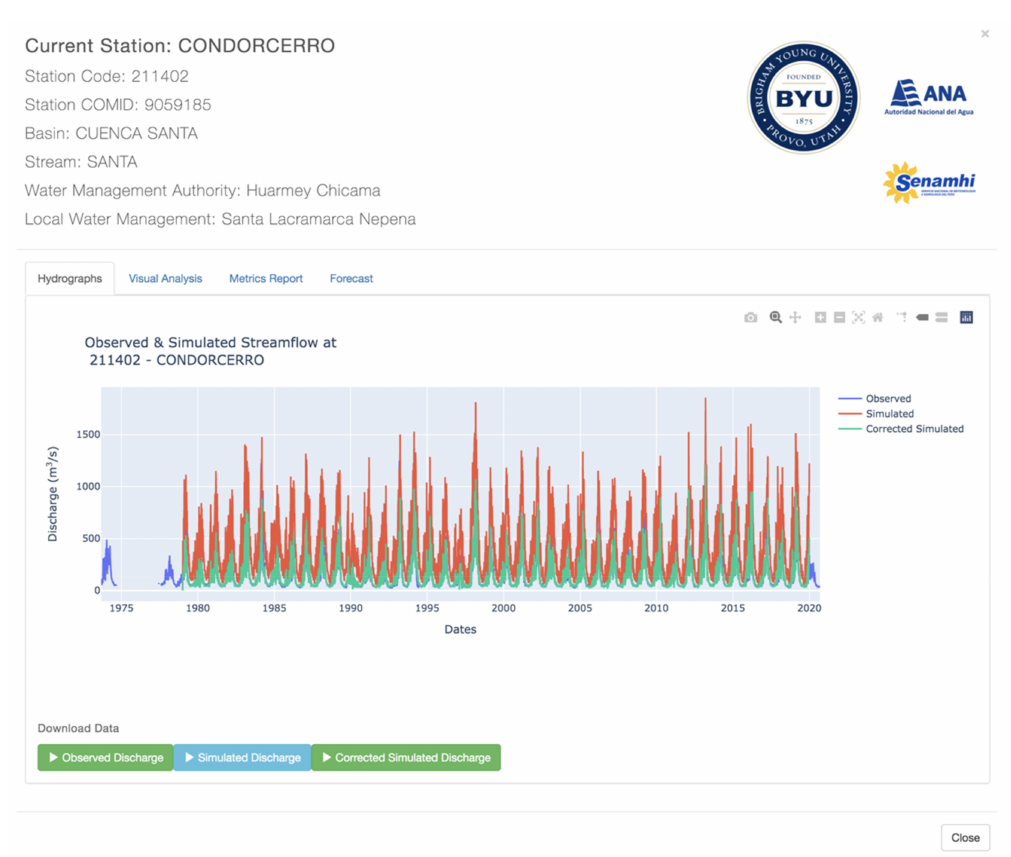
Figure 6. Hydrographs tab for the Condorcerro Station in the Historical Validation Tool App for